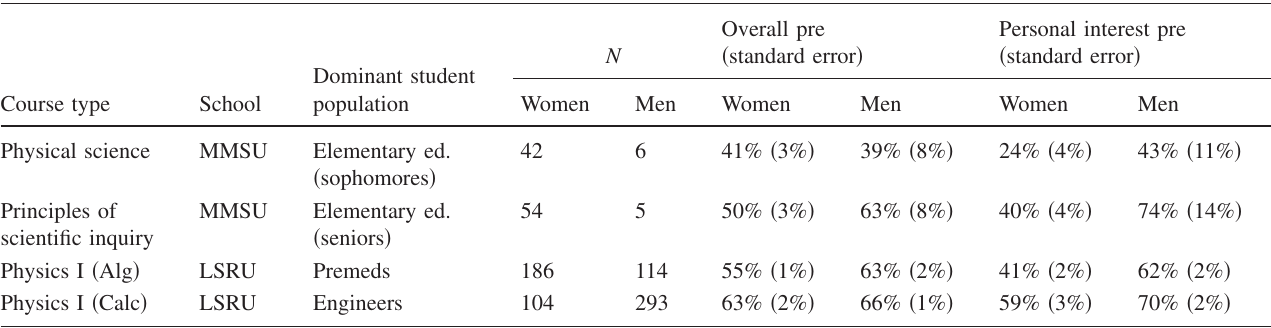
TABLE VIII. Relationships between favorable “personal interest,” physics course selection, and gender. Persent favorable shown for ease of